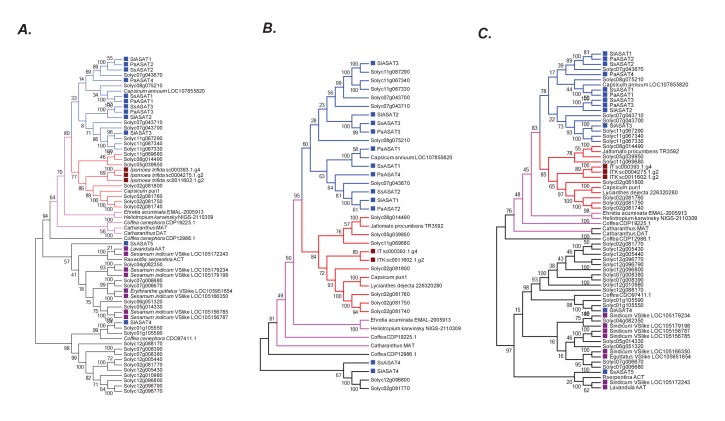
Robustness of the phylogenetic relationships.(A) A maximum likelihood tree obtained using the best model (JTT + G + I + F with five rate categories) as per maximum likelihood based search of multiple models. Sites with <70% coverage were deleted. (B) NJ tree using mostly the sequences in the pink +blue + red clade, with 100% site coverage and JTT model (C) NJ tree of all the sequences obtained using JTT. Only sites with 100% coverage were used for this analysis. Please see Figure 6A for explanation of the various branch and label colors. Bootstrap support values are a result of 100 iterations.